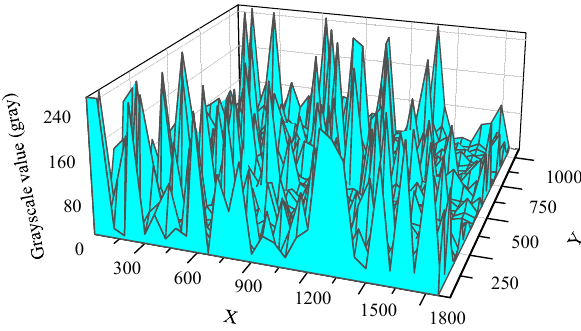
Figure 5. Mesh of overlapped radiation response events at a given time of 2500 s.